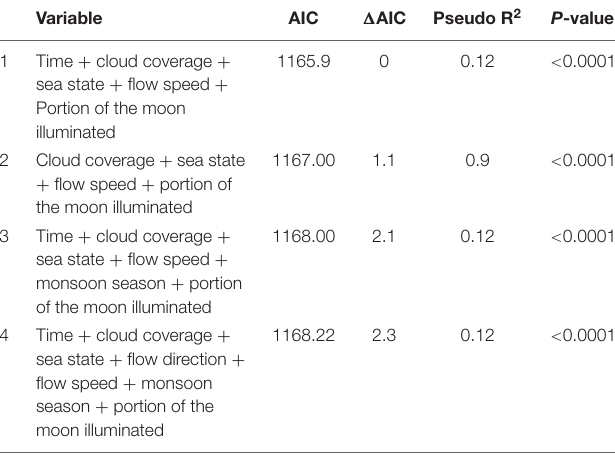
TABLE 2 | Model selection process for Tamis Rock cleaning station.